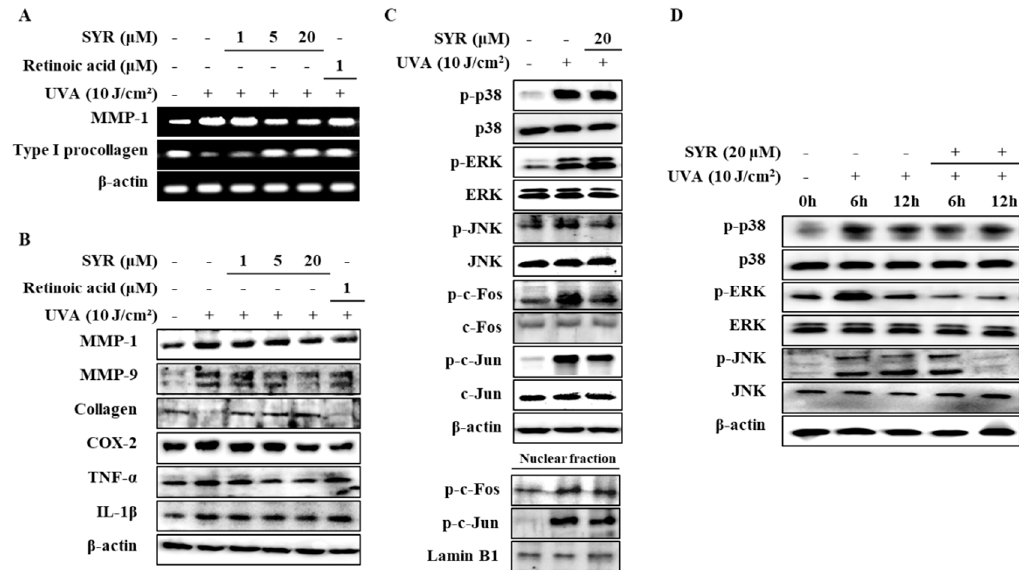
Figure 5. Effect of SYR on the expression of MMPs, type I procollagen, pro-inflammatory cytokines and MAPK/AP-1 phosphorylation in UVA-irradiated HDFs. ( A ) mRNA expressions of MMP-1 and type I procollagen were determined by RT-PCR. ( B ) Protein levels of MMP-1, MMP-9, collagen, COX-2, TNF- α , and IL-1 β were analyzed with Western blotting using total cell lysates. ( C , D ) Phosphorylated (p-) and total levels of p38, ERK, JNK, c-Fos and c-Jun were analyzed with Western blotting using total cell lysates and nuclear extracts. Cells were exposed to UVA radiation (10 J/cm 2 ) and treated with given concentrations of SYR. After 24 h ( A – C ) or 6 and 12 h ( D ) incubation cells were harvested for RT-PCR and Western blotting. Retinoic acid was used as a positive control. β -Actin was used as an internal control for RT-PCR and Western blotting. Lamin B1 was used as an internal control for nuclear fraction Western blots.